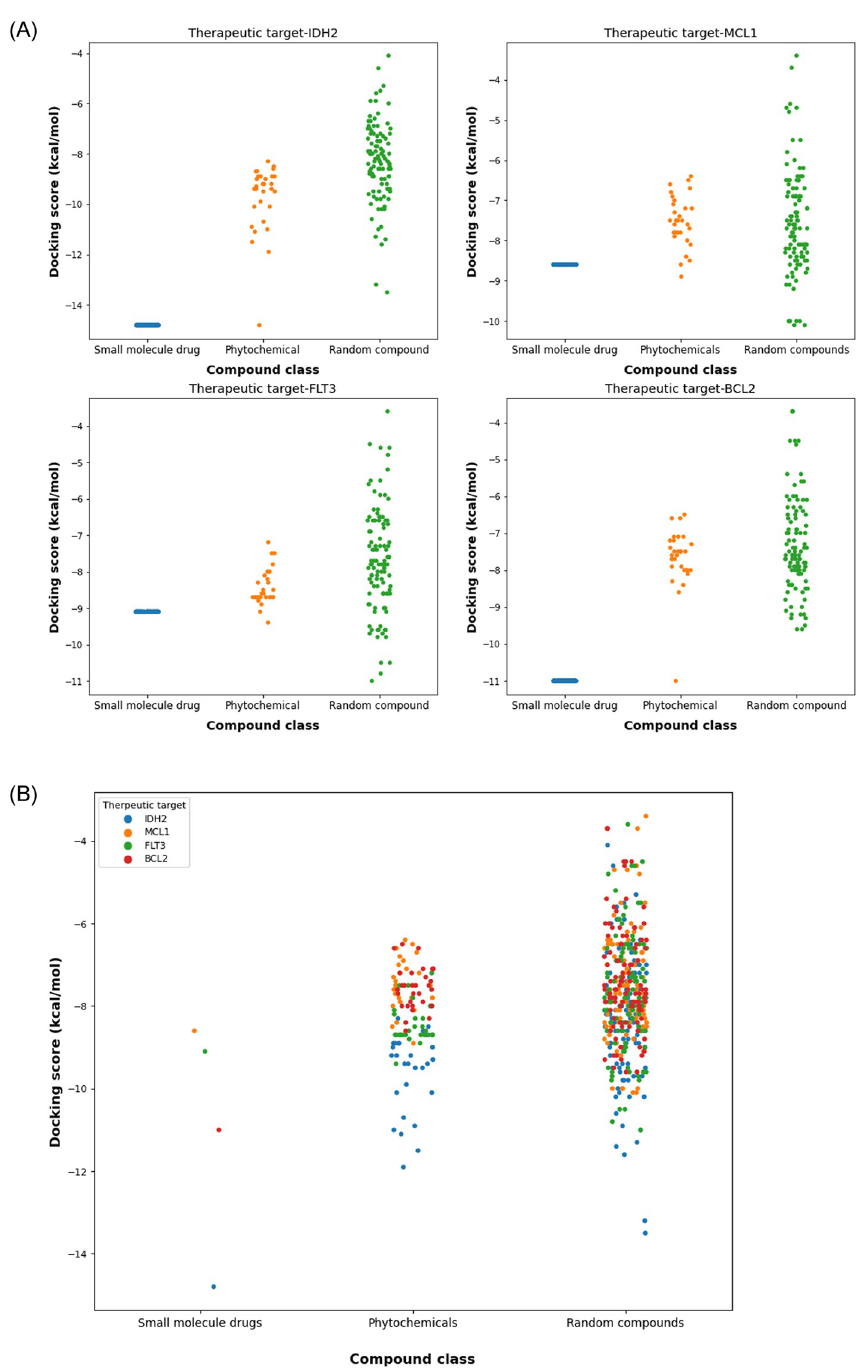
Fig 3. Scatter plots of the docking scores of compound-target interactions for each AML therapeutic targets. (A) compound—target docking score visualization for each AML targets, (B) compound—target docking scores combined for all the four AML